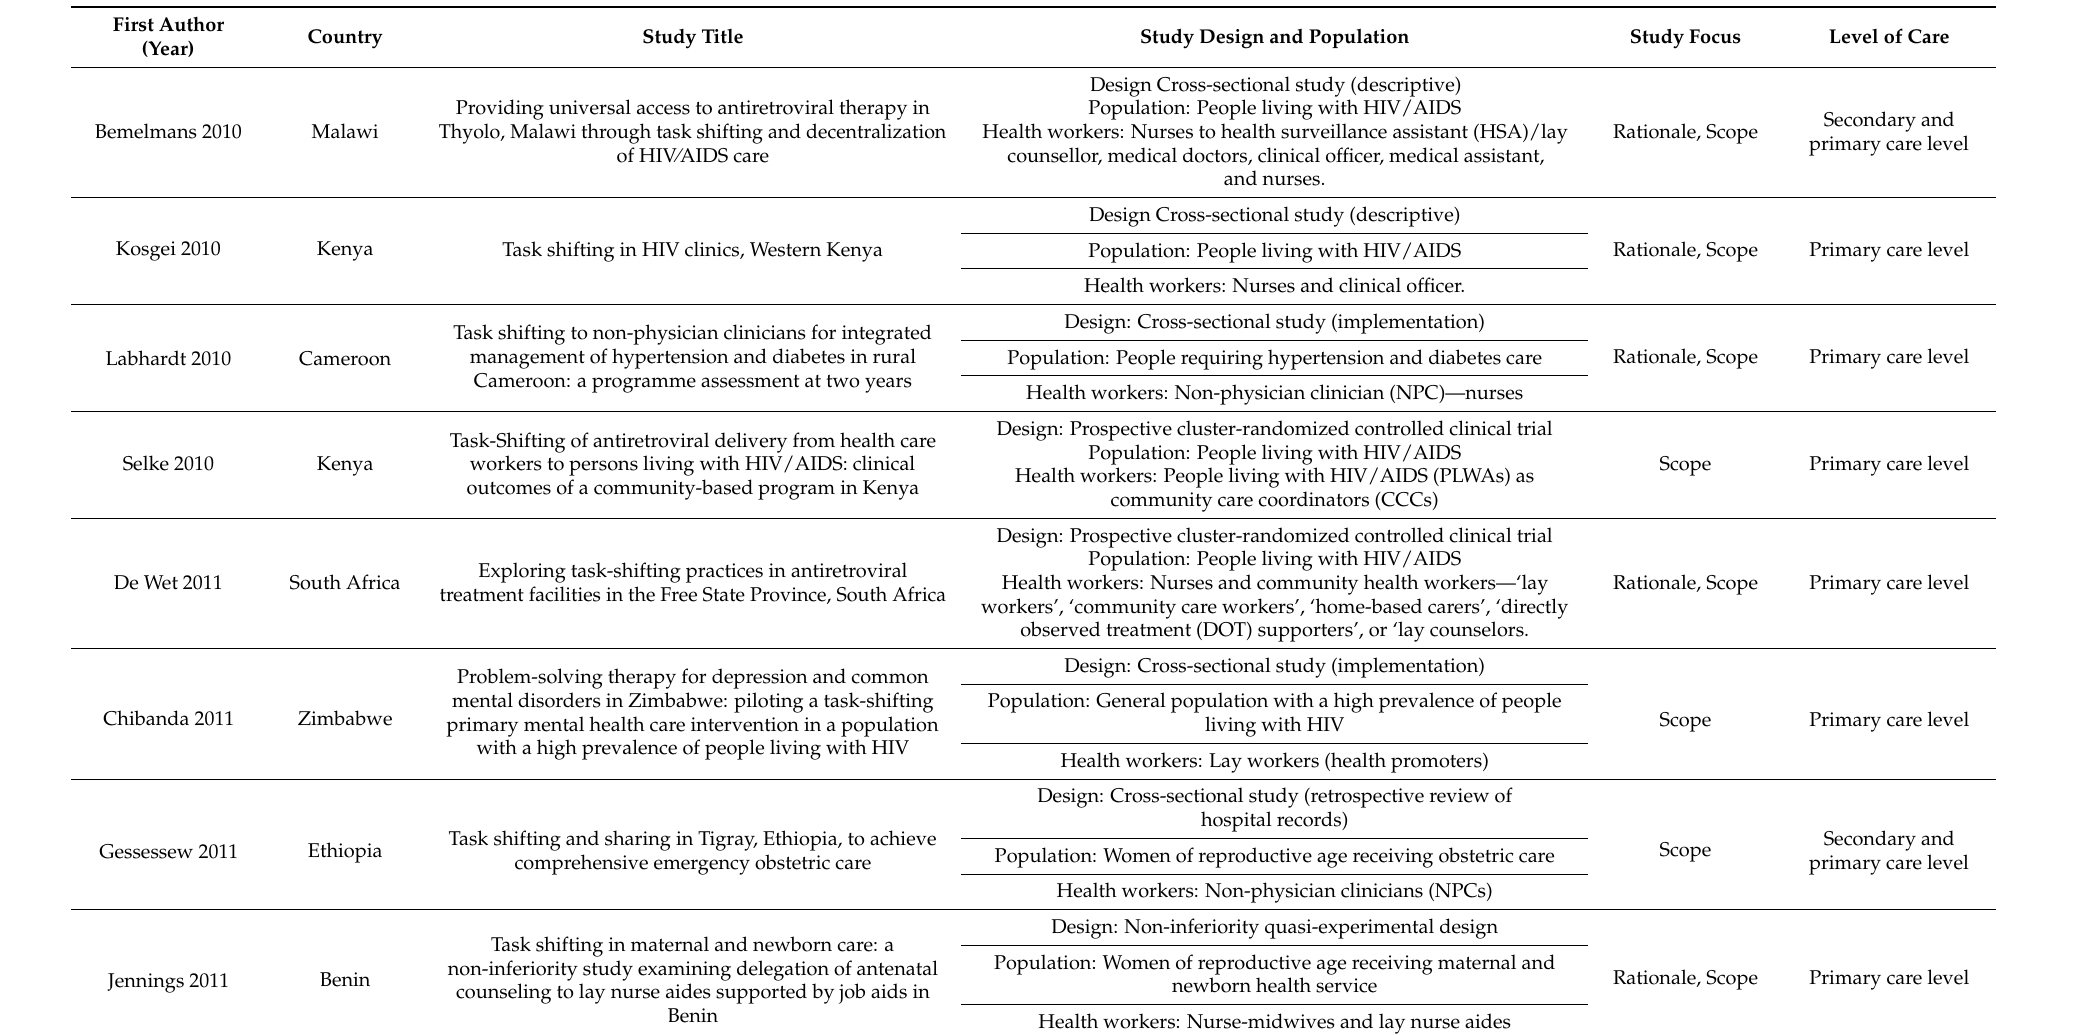
Table 4. Details on study